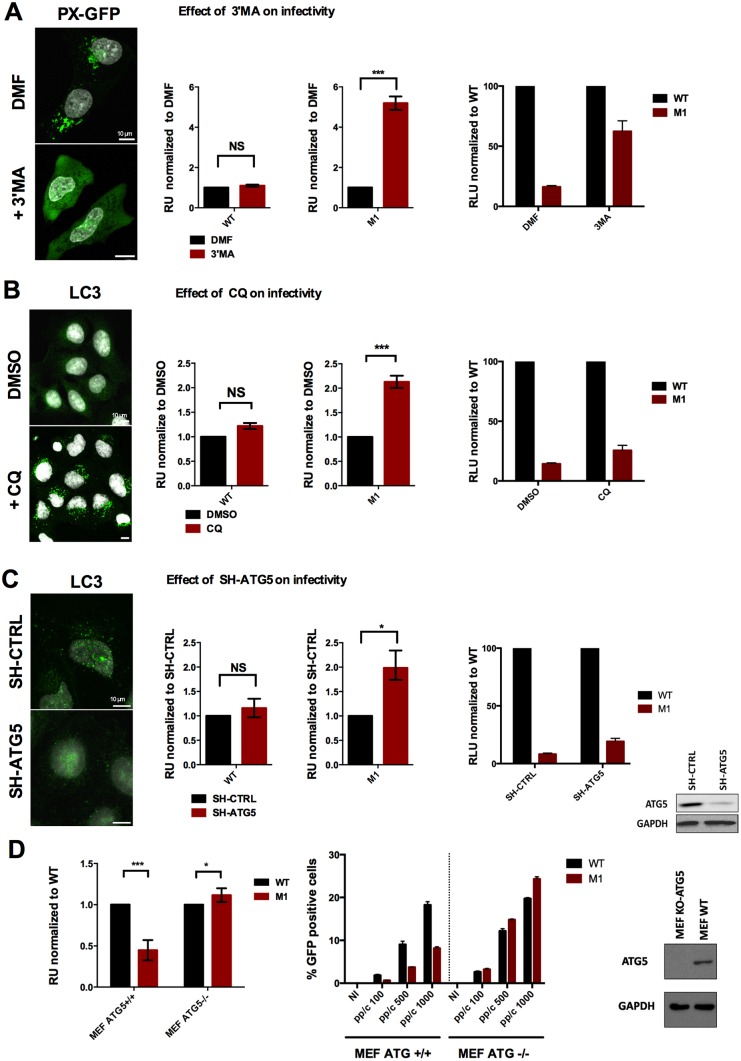
PPxY-mediated endosomal escape prevents autophagic degradation of incoming virions.(A) Left panel: U2OS cells expressing the Pi3P in cellulo binding probe PX-GFP were treated with vehicle (top) or with 5mM of the Pi3K inhibitor 3’MA (bottom). Middle panel: U2OS cells pre-treated with vehicle alone (black bars) or 3’MA (red bars) were transduced with WT or M1. Transgene expression was determined and normalized to vehicle treated controls to show the fold induction of infectivity upon treatment. Right panel: The same data as in the middle panel showing the level of M1 infectivity rescue compared to the normalized WT infectivity upon treatment. (B) Left panel: U2OS cells were treated with vehicle (top) or with chloroquine (CQ, 50μM, bottom) to block the autophagic flux, fixed and stained for LC3. Middle panel: Cells were treated with vehicle alone (black bars) or chloroquine (red bars) and transduced with WT or M1. Transgene expression was determined and normalized to vehicle treated controls to show the fold induction of infectivity. Right panel: The same data as in the middle panel showing the level of M1 infectivity rescue compared to normalized WT infectivity. (C) Left panel: U2OS cells depleted for ATG5 (SH-ATG5) or control depleted cells (SH-CTRL) and starved using HBSS during 4h, fixed and stained for LC3. Middle panel: Cells were transduced with WT or M1 and the relative transduction efficiency in SH-CTRL cells (black bars) and SH-ATG5 cells (red bars) was determined. Right panel: The same data as in the middle panel showing the level of M1 infectivity rescue compared to normalized WT infectivity. ATG5 expression levels were determined by western blot. (D) Left panel: Control MEFs (ATG5 +/+) and KO MEFs (ATG5 -/-) were transduced with WT or M1 as indicated and the relative transduction efficiency for the M1 (red bars) compared to the WT (black bars) was determined. Right panel: The panel shows the absolute number of transduced cells at indicated amounts of physical particles added to the cell (pp/c) for the WT (black bars) and the M1 (red bars) in ATG5 control (left) and KO (right) MEFs. ATG5 expression levels were determined by western blot.